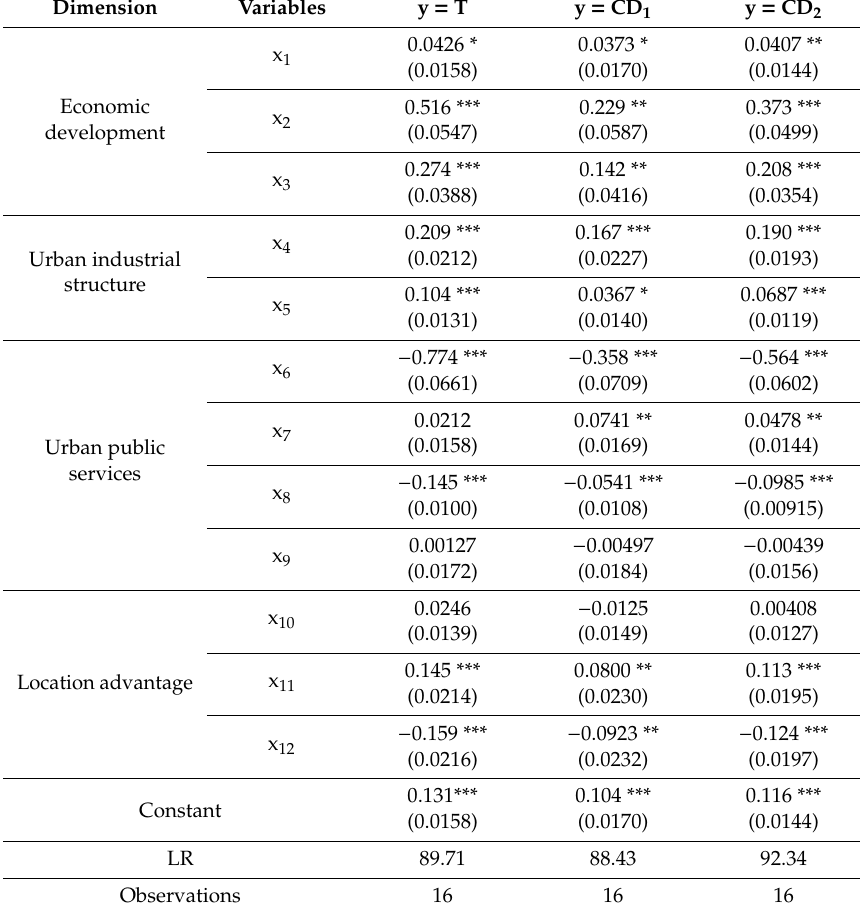
Table 5. The influencing factors of the coordination degree of